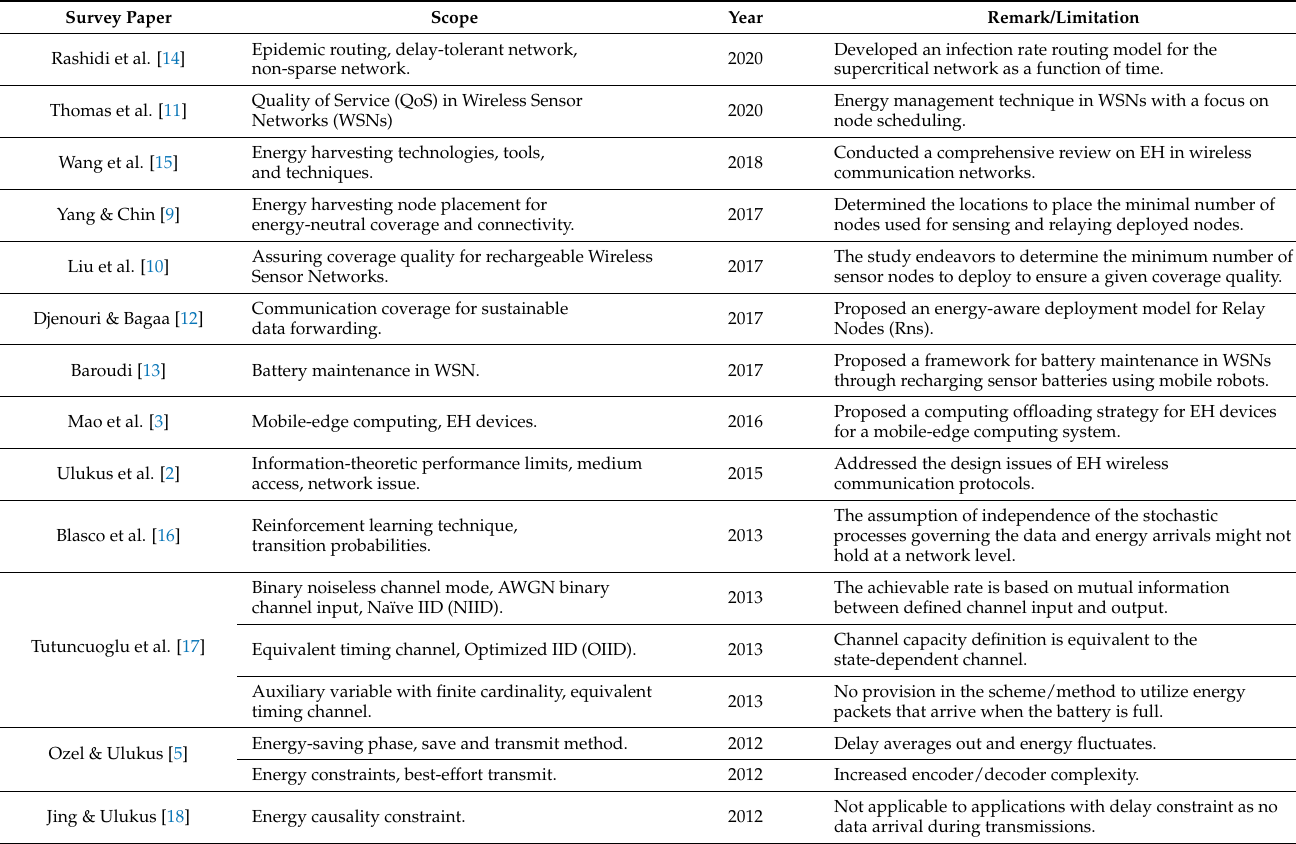
Table 1. Summary of related